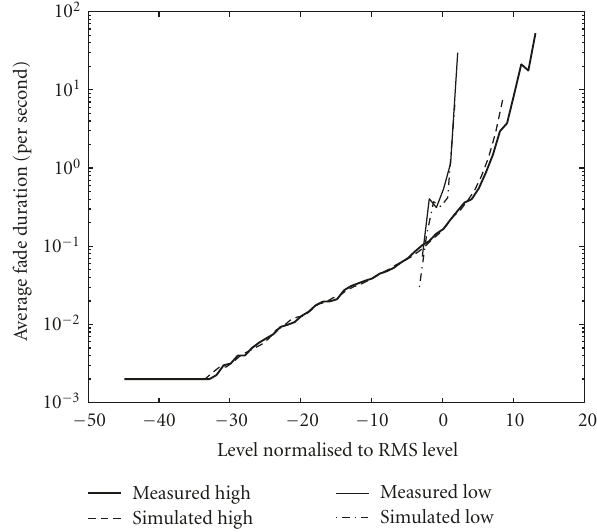
Figure 12: ACFs of measured (dry leaved deciduous trees (Site 1)) and simulated (using the new model) signals at 29 GHz during low ( w m = 2m/s) and high ( w m = 5 m/s) wind speed conditions. All simulation parameters are given in Table 3.